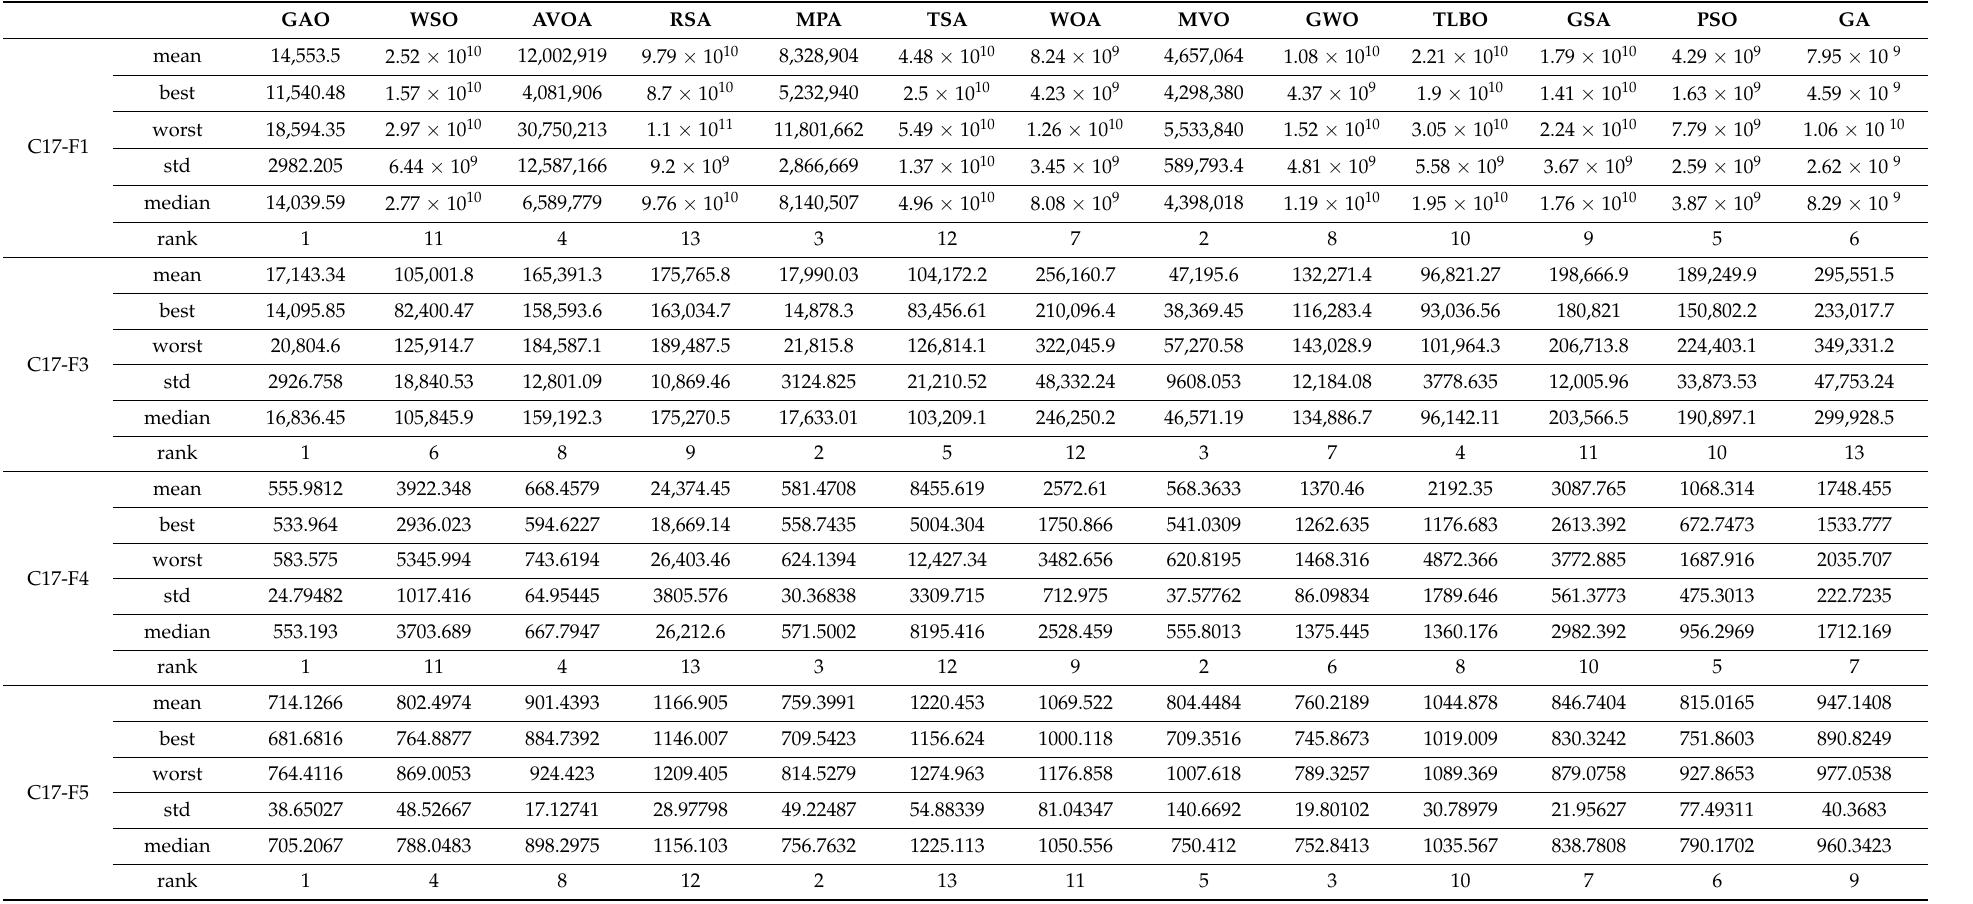
Table 4. Optimization results of the CEC 2017 test suite (dimension m =